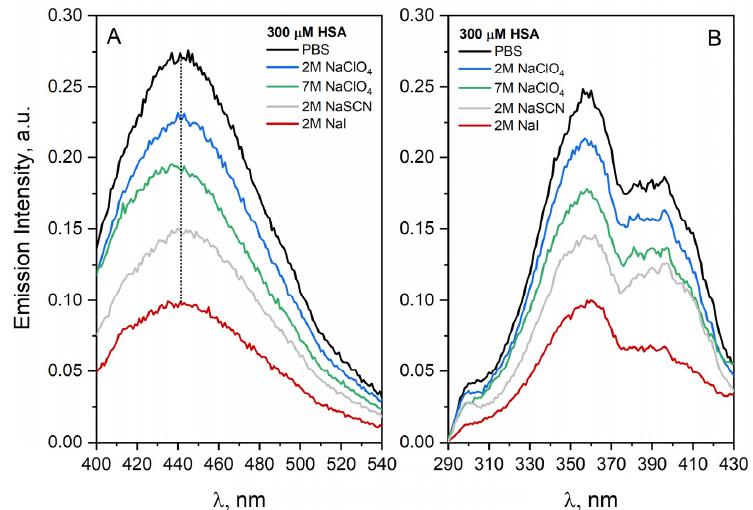
Figure 8. ( A ). Emission spectra of the HSA solutions (300 µM) containing NaClO 4 (2M, 7M), NaSCN (2M) and NaI (2M). The excitation wavelength 360 nm. ( B ). Emission excitation spectra of the HSA solutions (300 µM) containing NaClO 4 (2M, 7M), NaSCN (2M) and NaI (2M). The emission wavelength is 450 nm.